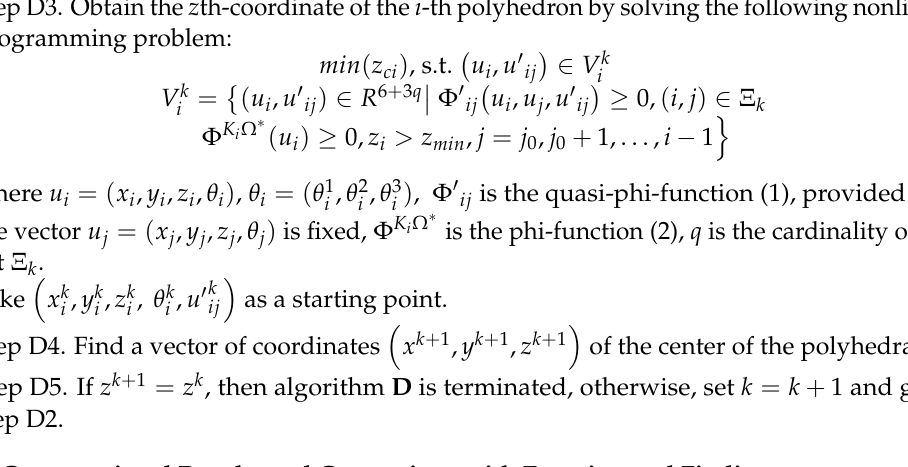
Algorithm D. Finding the minimal value of the z -th coordinate of a polyhedron using as a starting feasible